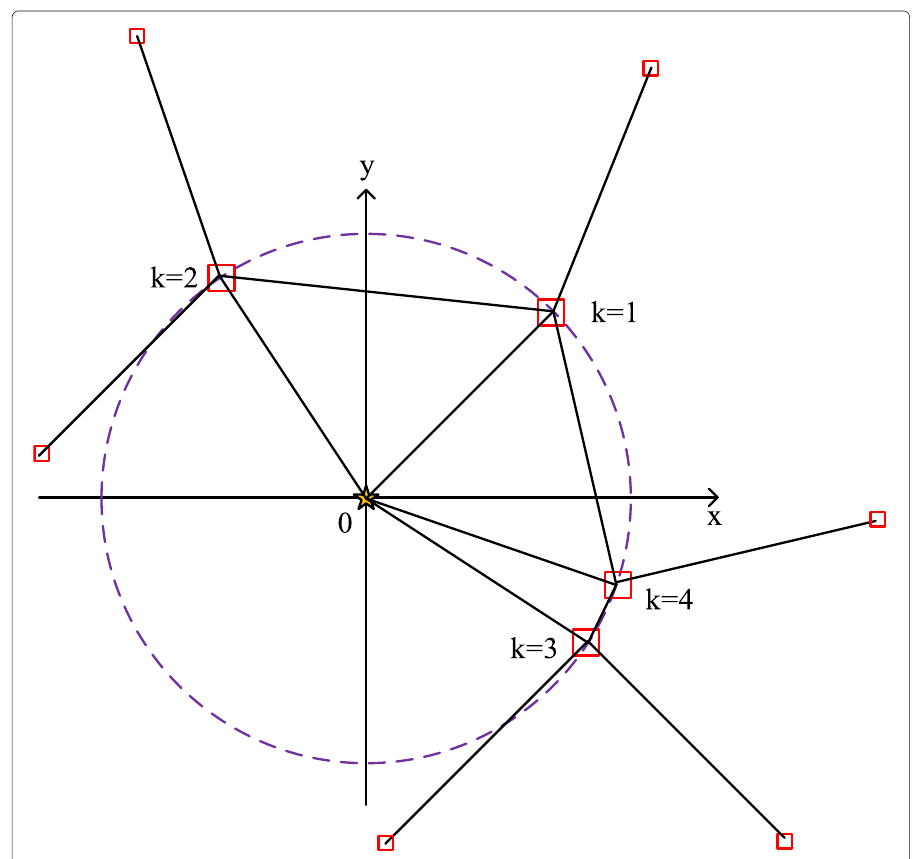
Fig. 3 A simple single anchor-based localization network: the yellow star indicates the single anchor, the bigger red square indicates a hearable agent for the anchor, the smaller red square indicates a nonhearable agent for the anchor, and a connection between two nodes indicates that both nodes are hearable to each